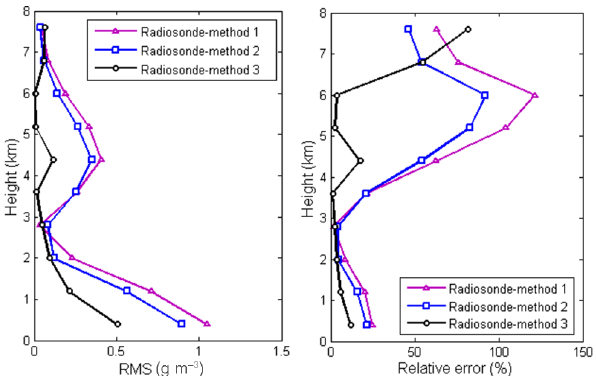
Figure 9. RMS error and MAE of water vapour density differences between radiosonde and three tomographic methods in the experi- ment.